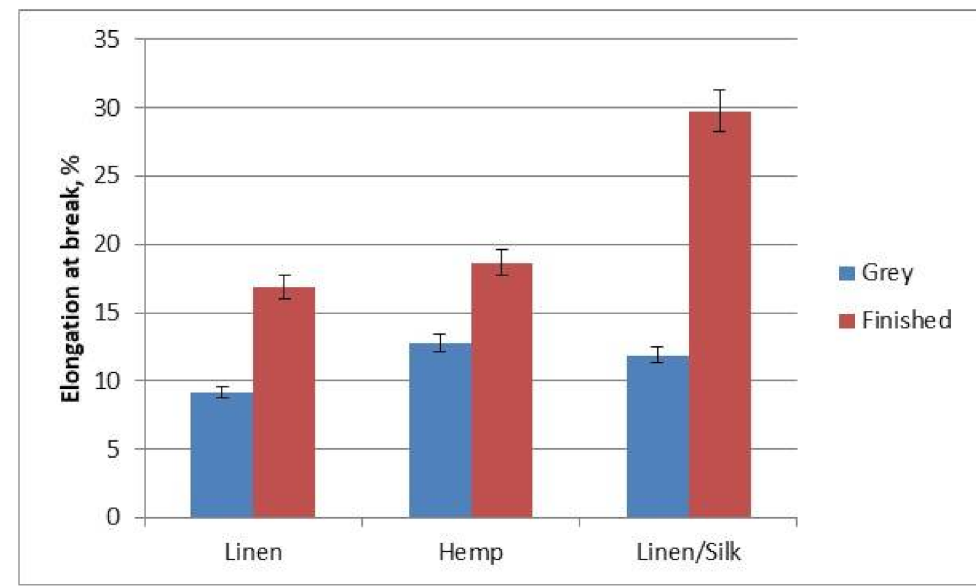
Figure 10. Diagram of the fabrics’ elongation at